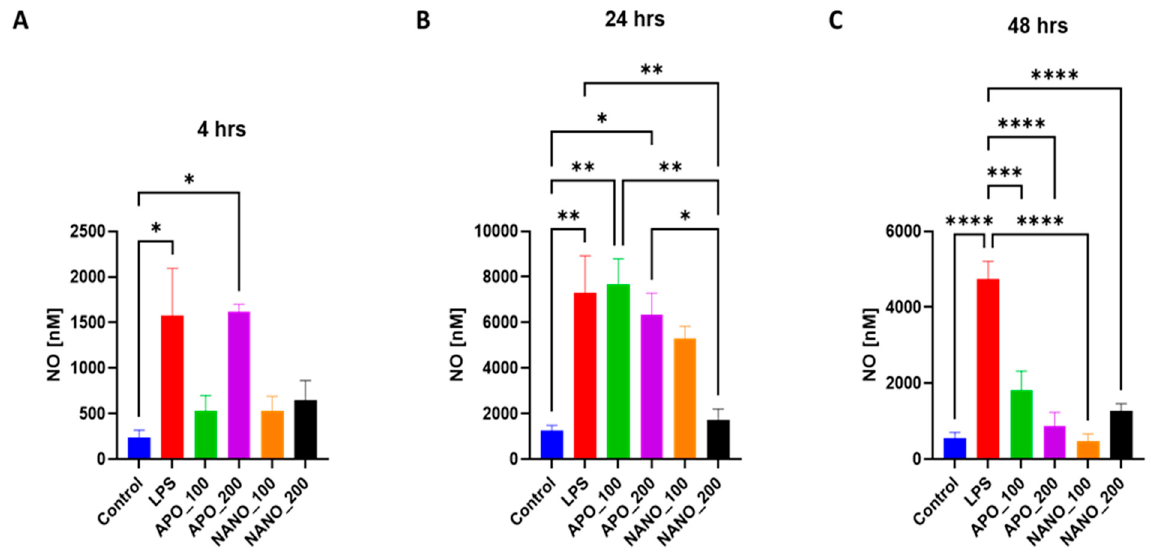
Figure 7. Measurement of NO production in injured neurons treated with the nanoparticle–apocynin conjugate. The primary cortical neurons were treated with either the PBS vehicle (control), 100 ng/mL of lipopolysaccharide, 100 mM of apocynin (APO_100), 200 mM of apocynin (APO_200), nanoparticles conjugated with 100 mM of apocynin (NANO_100), or nanoparticles conjugated with 200 mM of apocynin (NANO_200). The amounts of NO produced were measured at ( A ) 4, ( B ) 24, and ( C ) 48 h. The data were analyzed using a one-way ANOVA with Tukey’s multiple comparisons test. The results are presented as mean values (± SEM, N = 4 experiments). Significant differences are indicated by * p ≤ 0.05, ** p ≤ 0.01, *** p ≤ 0.001, and **** p ≤ 0.0001.